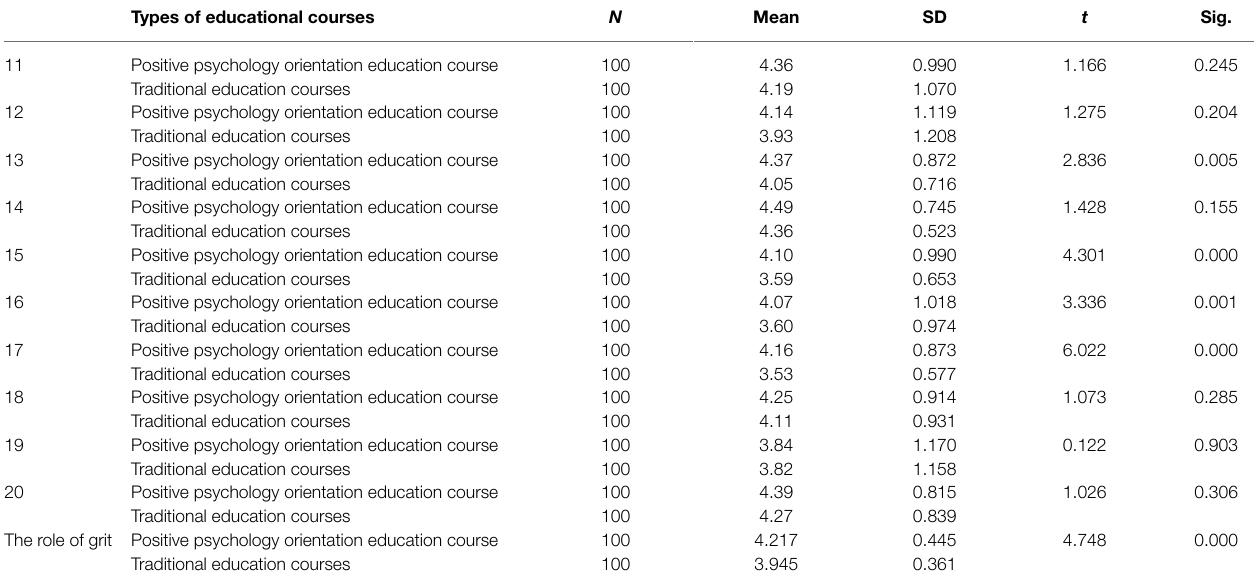
TABLE 3 | Difference analysis results of students’ grit feelings in different educational courses. Types of educational